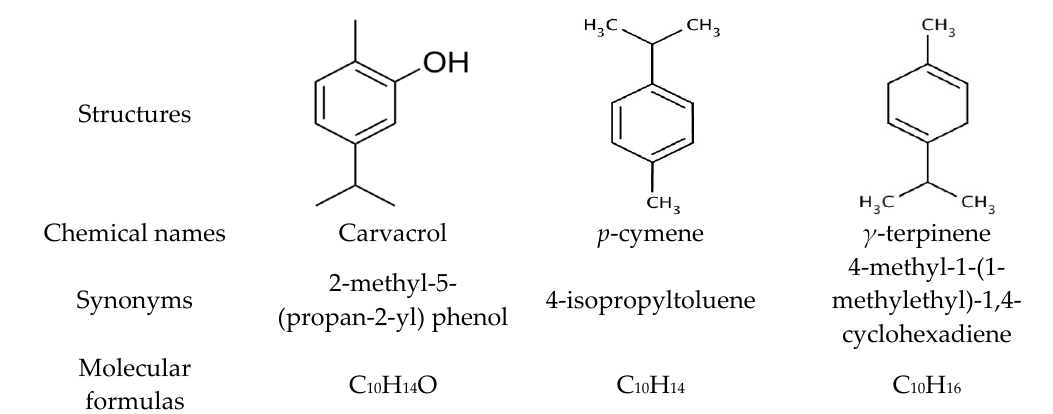
Figure 2. Chemical structures of major components identified in Thymus vulgaris essential oil.